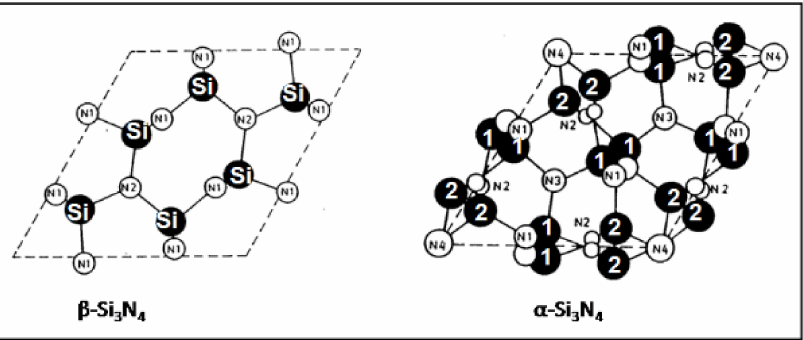
Figure 1. Arrangement of Si and N atoms in hexagonal β - and α -silicon nitride shown projected down the c axis onto the AB plane [6]. © With permission from